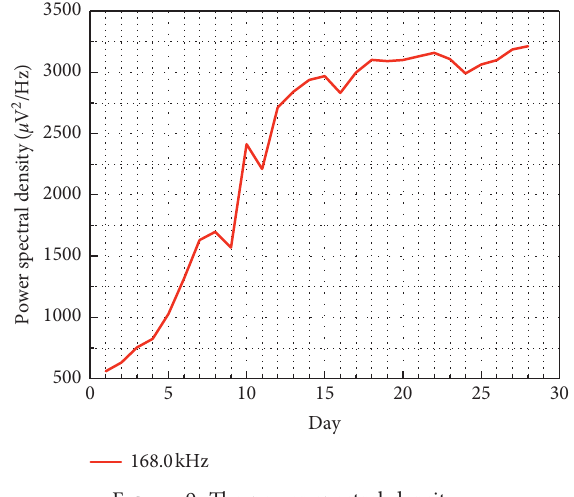
Figure 9: The power spectral density.